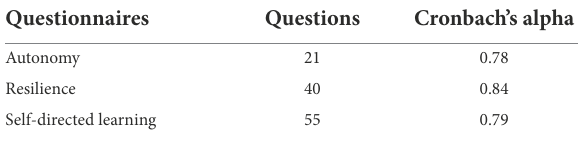
TABLE 1 Cronbach’s alpha calculated for research